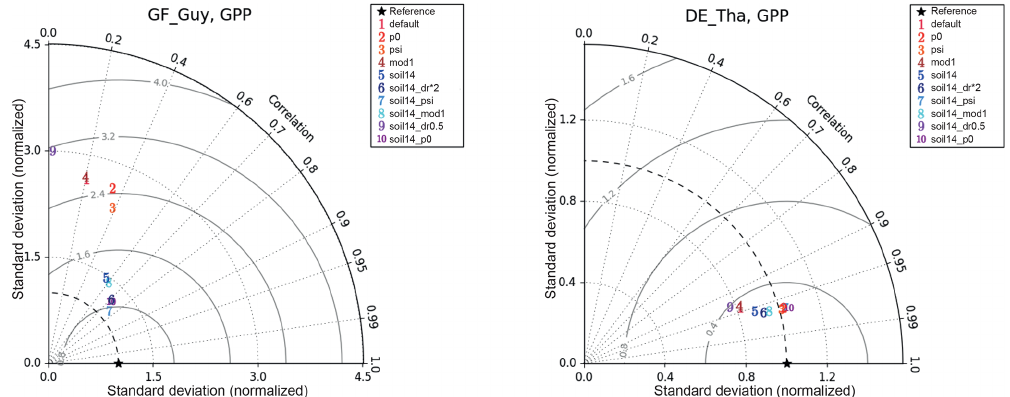
Figure 7. Example of impacts of soil moisture stress representations on GPP model skill for two soil-moisture-stressed sites: GF-Guy (tropical evergreen forest) and DE-Tha (temperate evergreen needleleaf forest). The GF-Guy simulations included the years 2007–2009, and the DE-Tha simulations included the years 1996–2014. Details of the simulations are provided in Sect. 2.3 and Tables 1–2. The solid lines indicate the centered rms error (based on the normalized standard deviations).